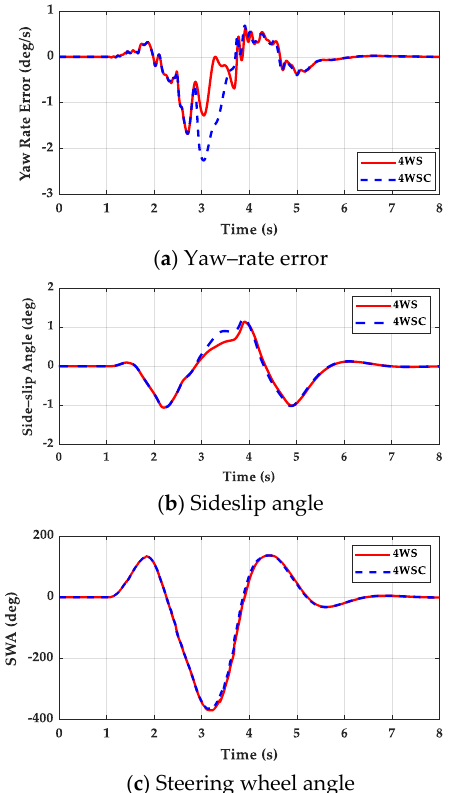
Figure 4. Simulation results for unconstrained (4WS) and constrained (4WSC) cases.